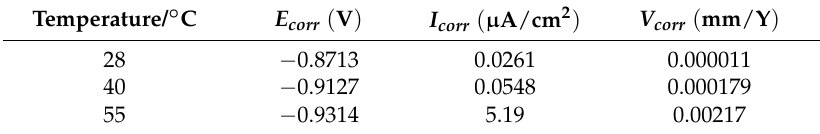
Table 5. Corrosion parameters of anodized aluminum in solution with different